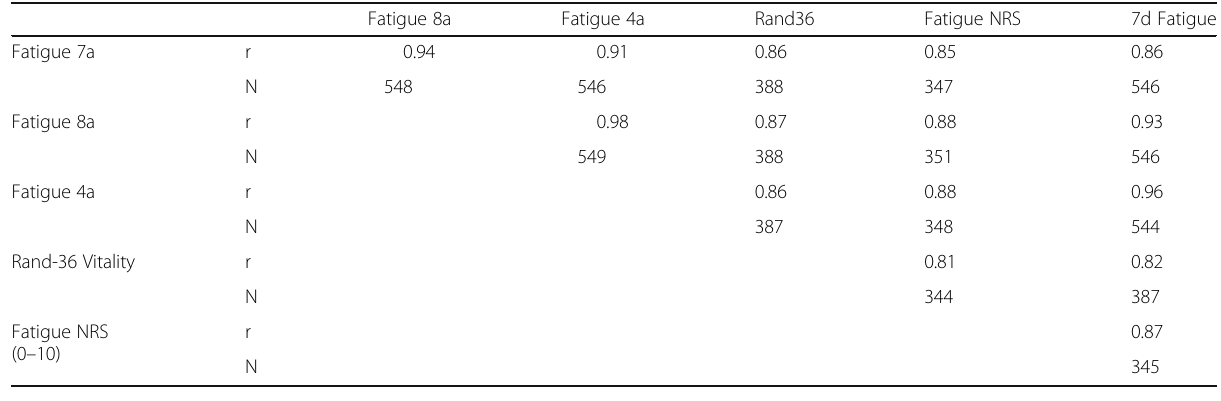
Table 3 Correlations among PROMIS fatigue 7a, 8a, 4a, Rand Vitality and 10-point fatigue scores